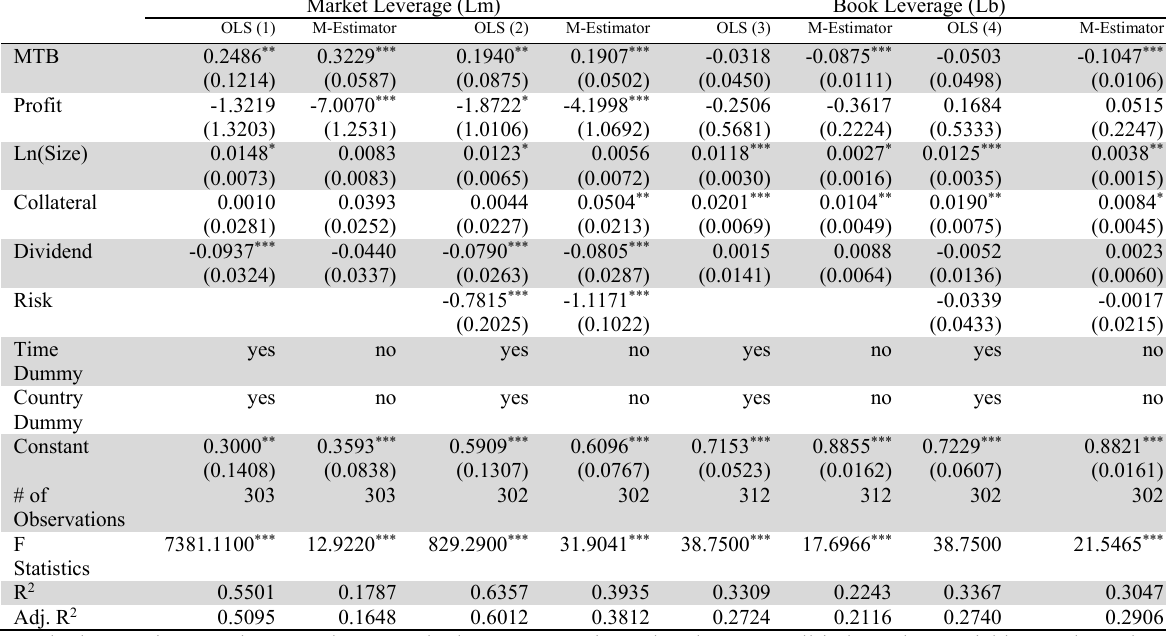
Determinants of Market and Book Leverage in Islamic Banks Market Leverage